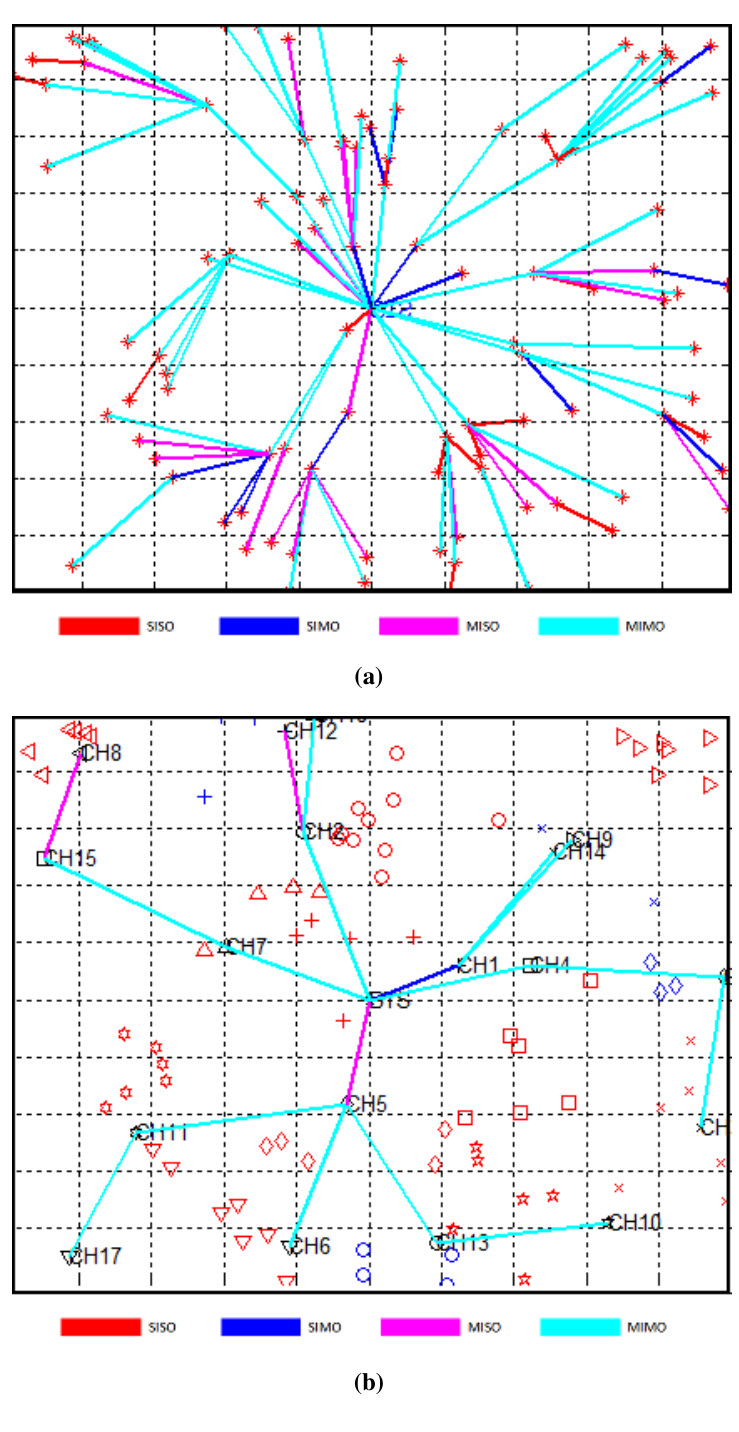
Figure 8. Comparison of Routing Nodes in CMIMO and HMIMO. (a) Routing in CMIMO; (b) Routing in HMIMO via backbone